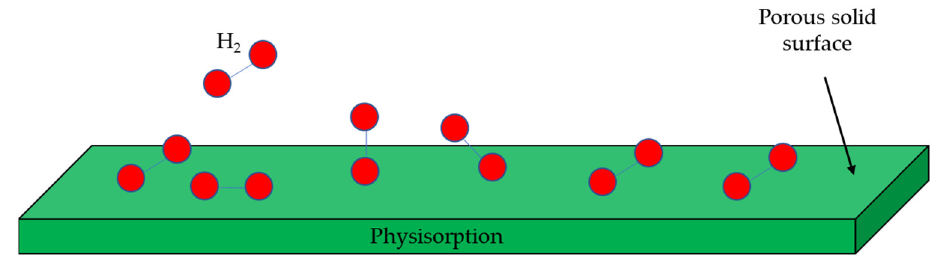
Figure 13. Physisorption process.